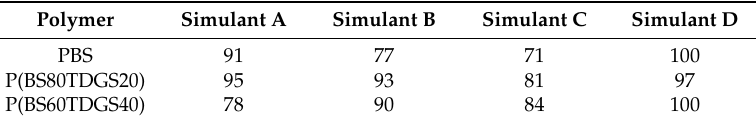
Table 2. Residual M n (%) after the treatment with food simulants.